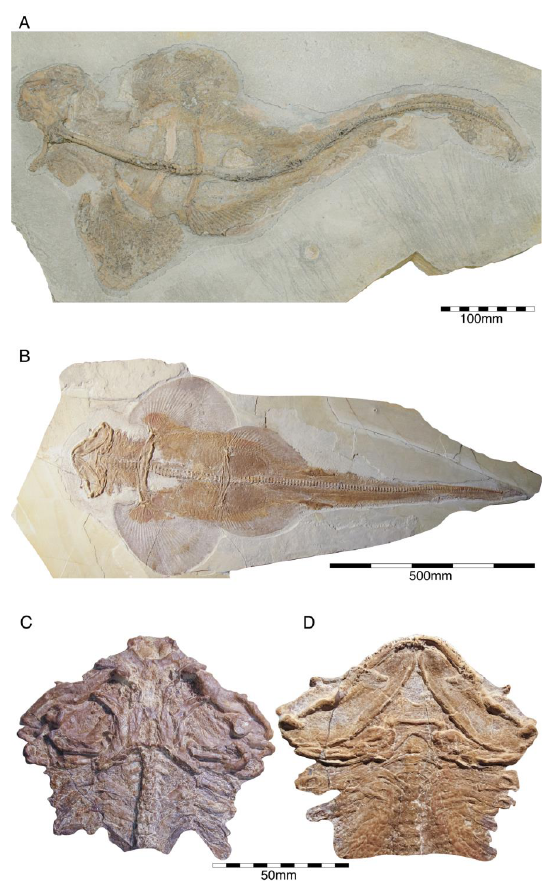
Figure 29. Specimens of † Pseudorhina Jaekel, 1989 [276]. ( A ) Holotype specimen of † P. alifera (Münster, 1842 [50]) (SNSB-BSPG AS VII 3) from the lower Tithonian of Eichstätt. ( B ) † Pseudorhina acanthoderma (Fraas, 1854 [64]) (SMNS 80431/20) from the upper Kimmeridgian of Nusplingen. ( C ) Close up of the cephalic region in dorsal view of † P. acanthoderma (SMNS 86214/41) from the Kimmeridgian from Nusplingen. ( D ) Close up of the cephalic region in ventral view of † P. acanthoderma (SMNS 80431/20).